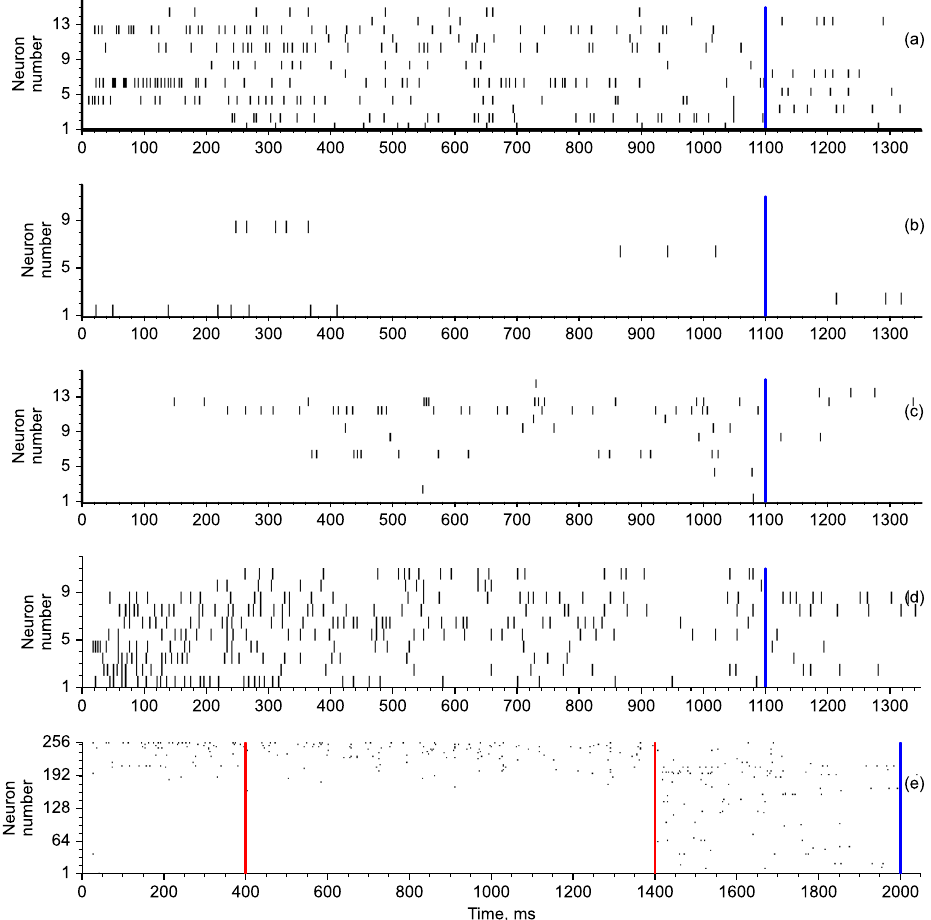
Figure 6. Spiking sequences of two neural subgroups of the trained network when performing the DM 1 task ( a , b ) and the Go 2 task ( c , d ). The first subgroup dynamics are given by ( a ) and ( c ), and the second subgroup dynamics are given by ( b ) and ( d ). ( e ) Full network spiking activity when performing the Romo 1